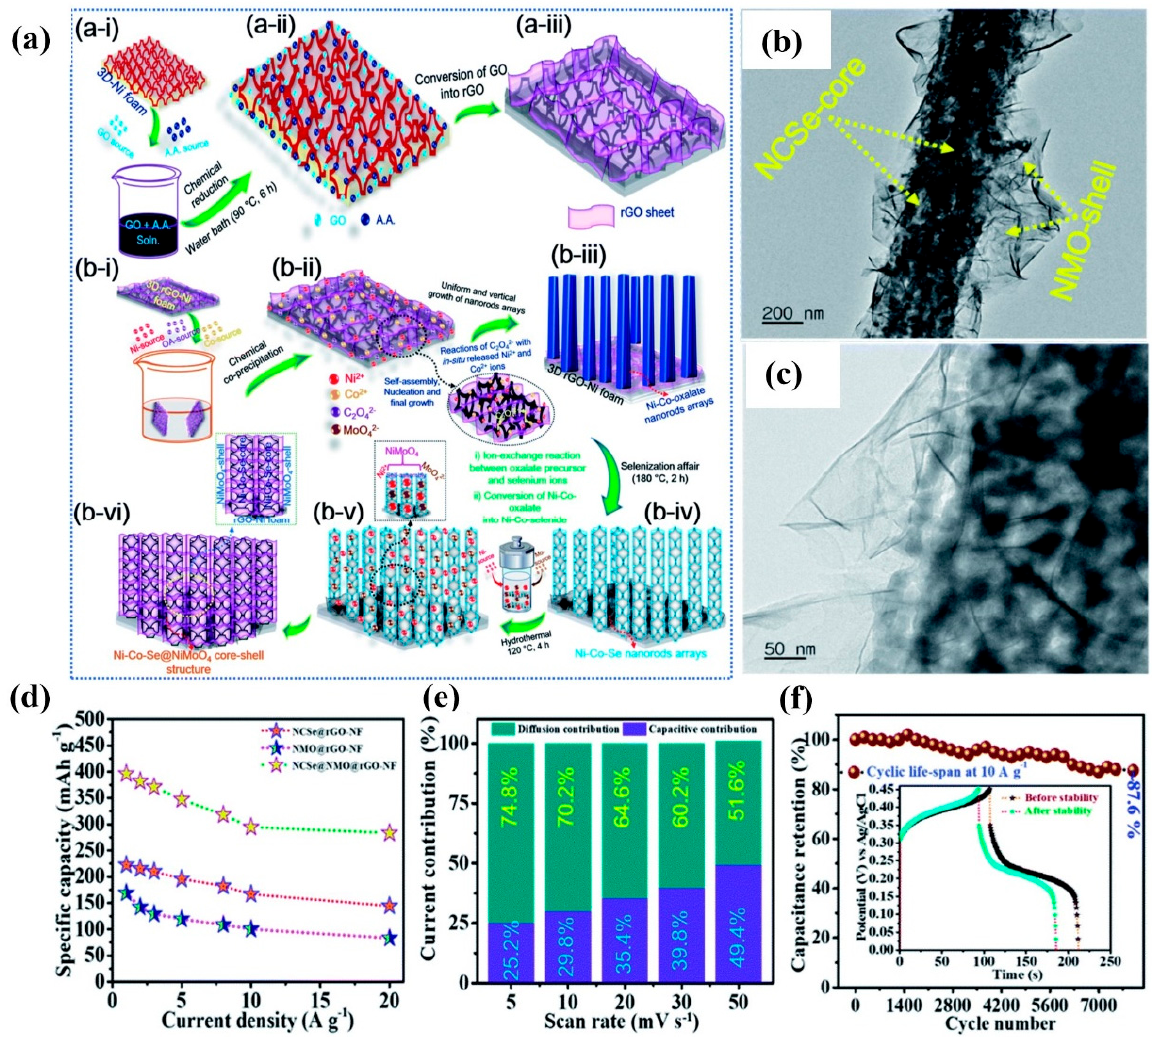
Figure 7. ( a ) Schematic diagram of the synthesis of the Ni − Co − Se − NiMoO 4 − rGO − NF, ( b , c ) TEM images, ( d ) rate capability curves, ( e ) diffusion and capacitive current contributions, and ( f ) cycling performance at 10 Ag − 1 [137]. Reproduced from Ref. [137] with permission from The Royal Society of Chemistry, 2022. Table 2. Electrochemical performances of core-shell structures using composites of NiMoO 4 -metal hydroxide, NiMoO 4 -metal chalcogenide, NiMoO 4 -carbon material, NiMoO 4 -conductive polymer for supercapacitors.